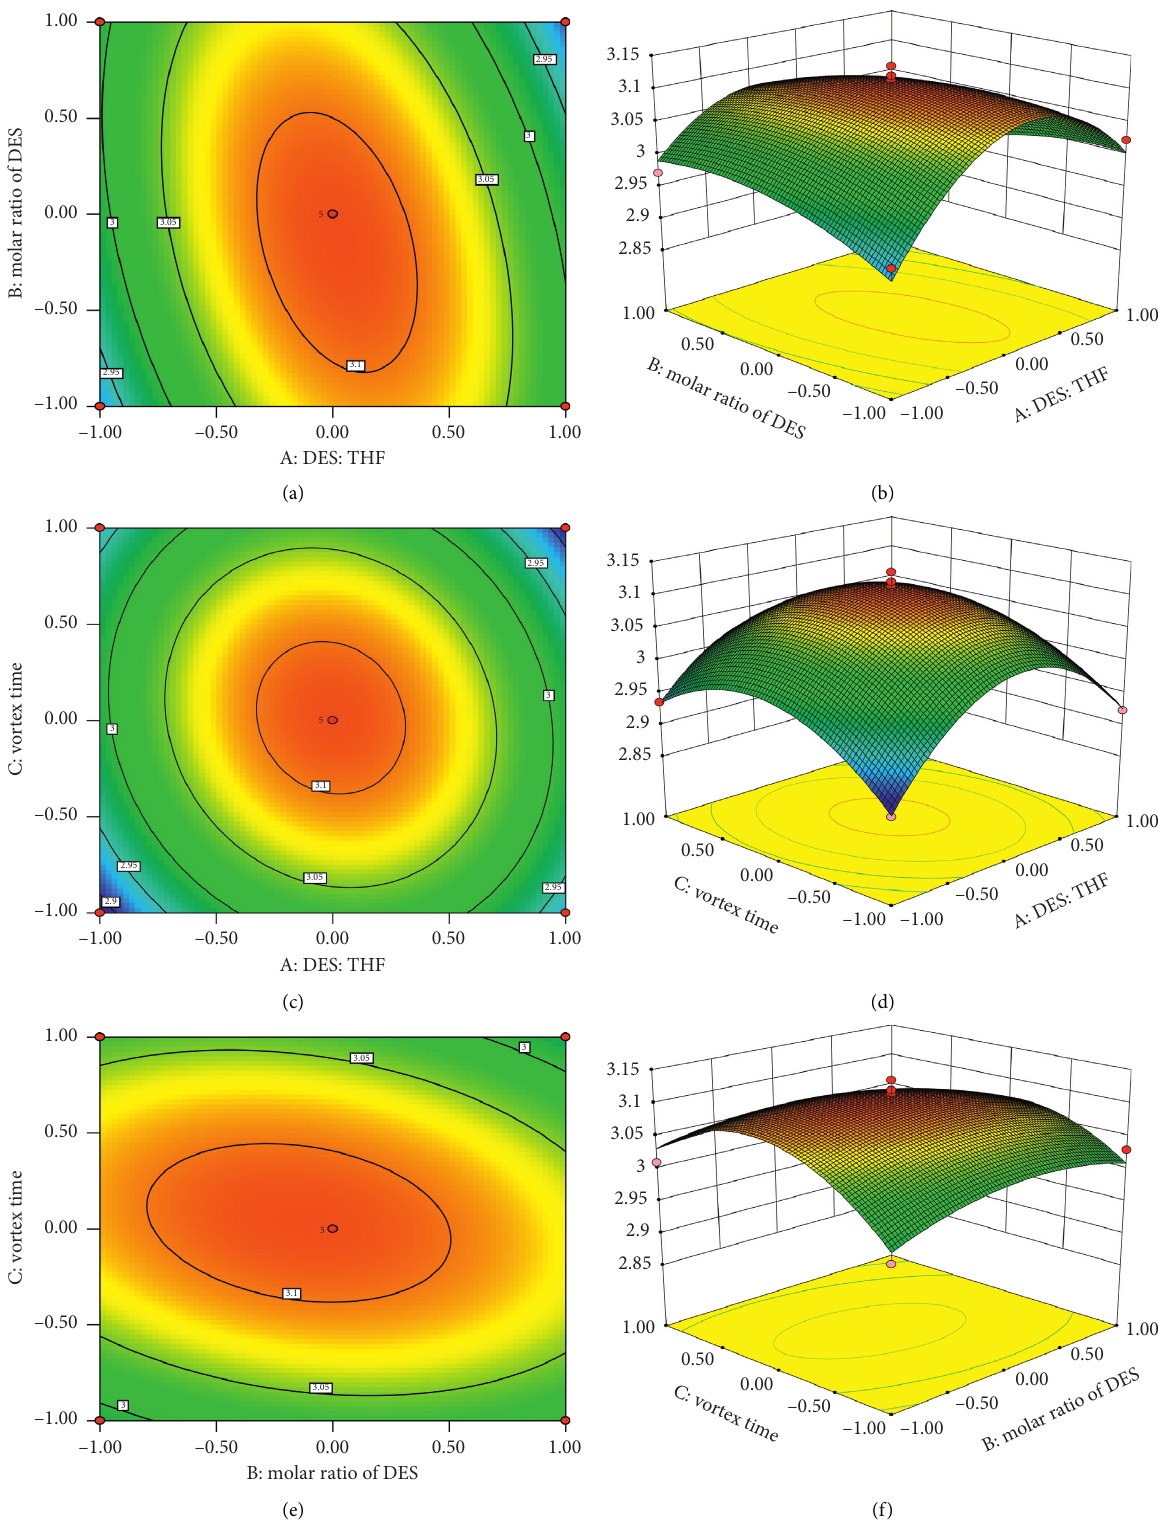
Figure 4: Response surface and contour of the interaction of various